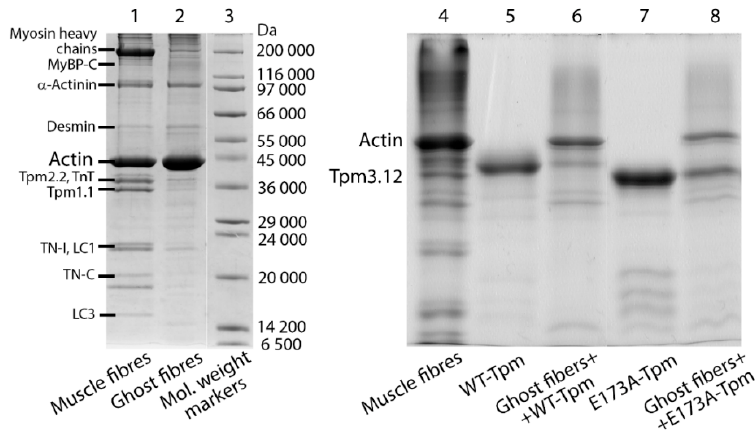
Figure 2. Verification of the incorporation of recombinant Tpm into the ghost muscle fibres. The SDS-PAGE shows the results of electrophoretic separation of muscle fibre isolated from m. psoas of rabbit (lanes 1 and 4), fibres after extraction of myosin and regulatory proteins of thin filaments (ghost fibres, lane 2), ghost fibres reconstituted with the recombinant wild-type (lane 6) and mutant (lane 8) tropomyosin incorporated in thin filaments, and the recombinant tropomyosin preparations per se (lanes 5 and 7) as well as molecular weight markers (Sigma-Aldrich, St. Louis, MO, USA, lane 3). Designations: MyBP-C—myosin-binding protein C; LC1 and LC3—myosin light chains; Tpm1.1, Tpm2.2 and Tpm3.12—tropomyosin isoforms; troponin (TN)-T, TN-I and TN-C—troponin subunits.